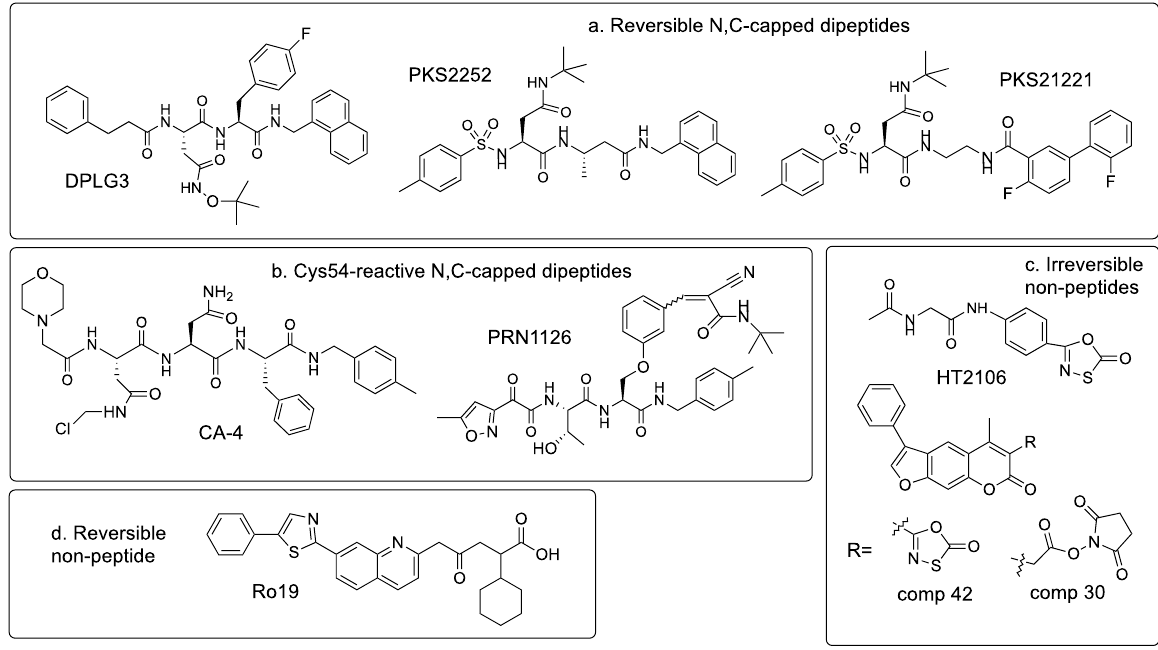
Figure 6. Additional β 5i inhibitors. ( a ). Reversible N,C-capped dipeptides. ( b ). Cys54-reactive N,C- capped dipeptides. ( c ). Irreversible non-peptide inhibitors. ( d ). Reversible non-peptide inhibitors.